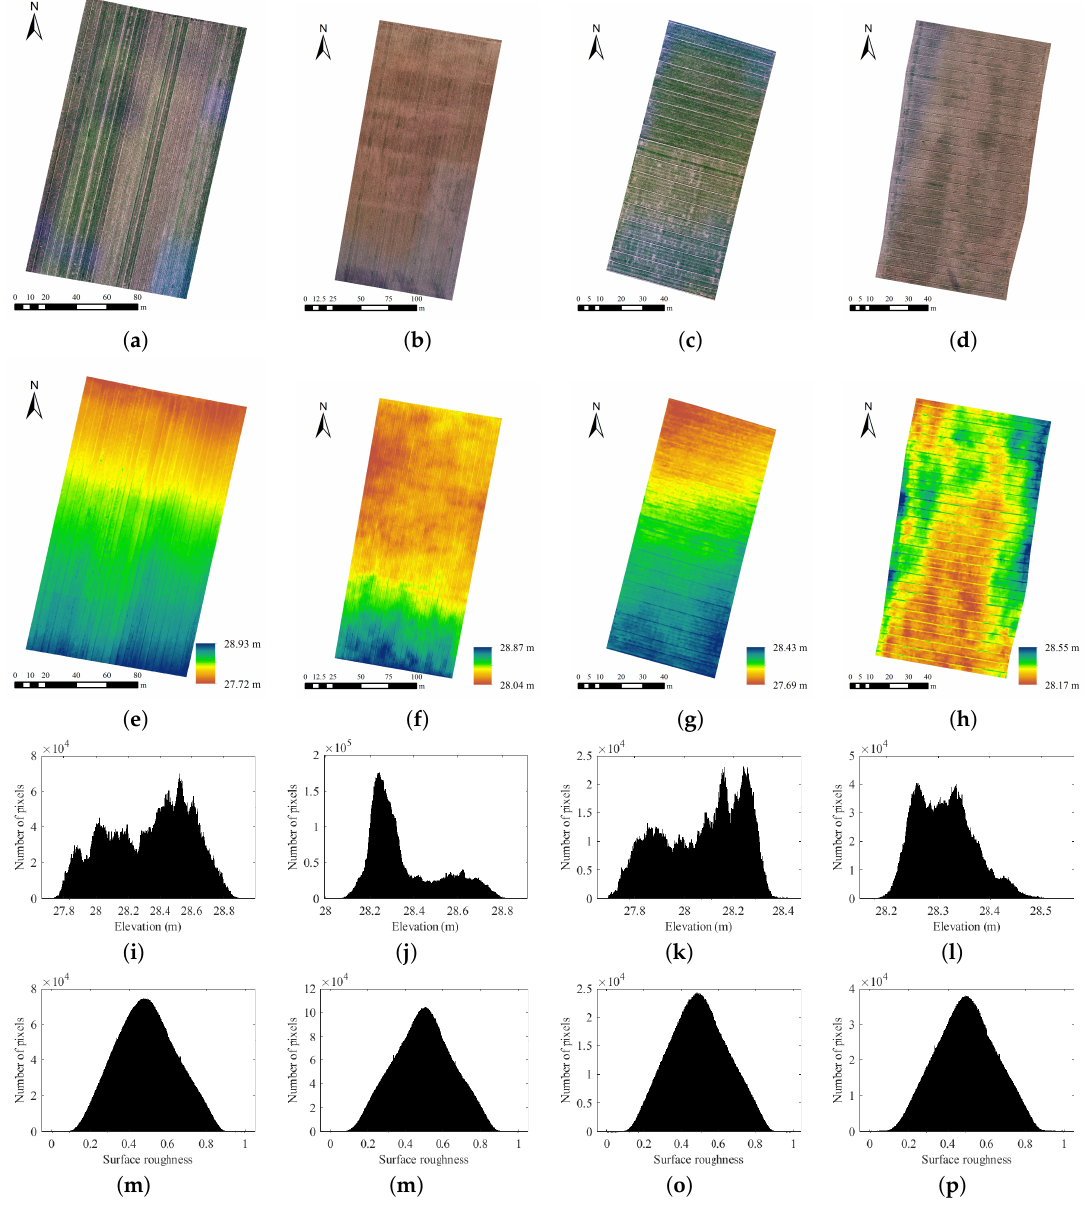
Figure 5. Plot images of orthophoto for Plot 1 ( a ), Plot 2 ( b ), Plot 3 ( c ), Plot 4 ( d ), DSM for Plot 1 ( e ), Plot 2 ( f ), Plot 3 ( g ), Plot 4 ( h ), elevation histogram for Plot 1 ( i ), Plot 2 ( j ), Plot 3 ( k ), Plot 4 ( l ), and surface roughness histogram for Plot 1 ( m ), Plot 2 ( n ), Plot 3 ( o ), Plot 4 ( p